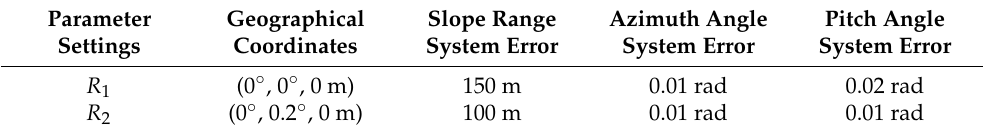
Table 1. Simulation scene parameters.